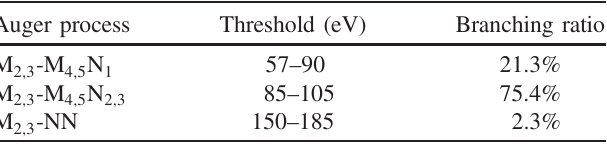
TABLE II. Analysis of the Auger decay following photoioni- zation from the 3 p core shell.